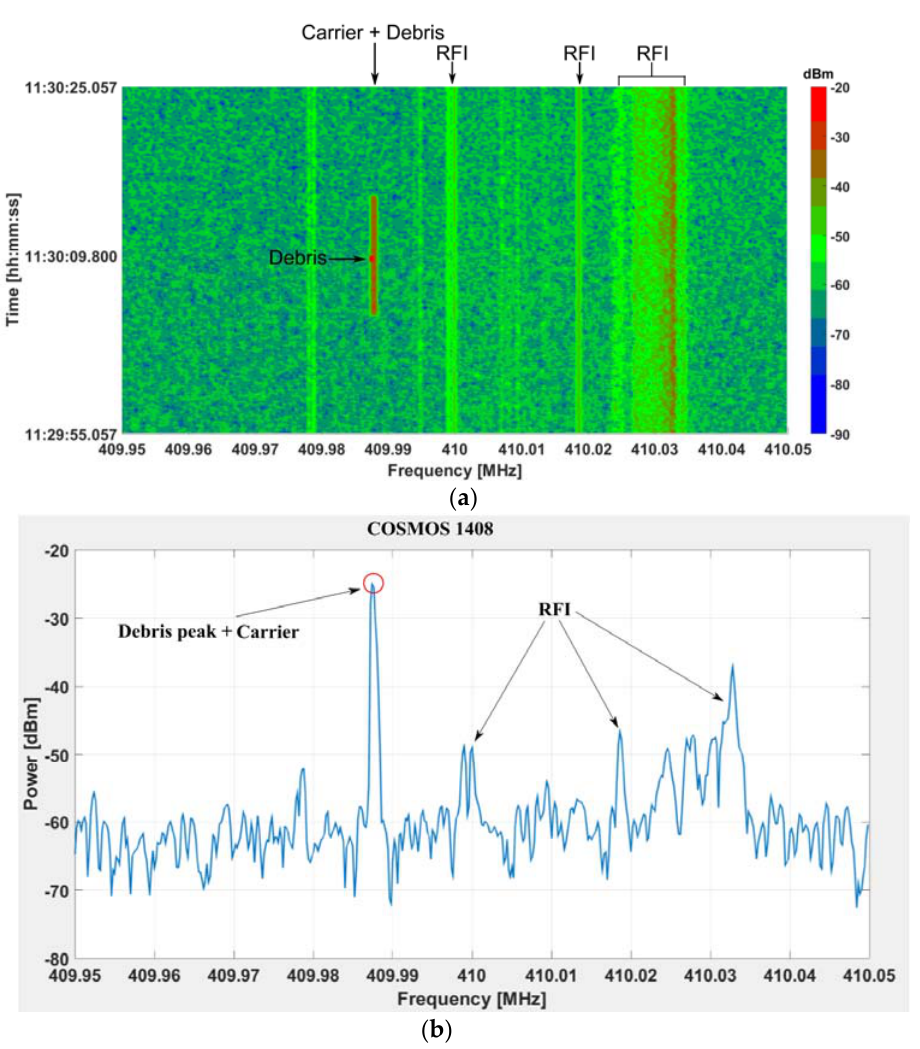
Figure 8. Debris COSMOS 1408: ( a ) spectrogram; ( b ) screenshot of the spectrum analyzer at the center of the visibility interval (Table 4).